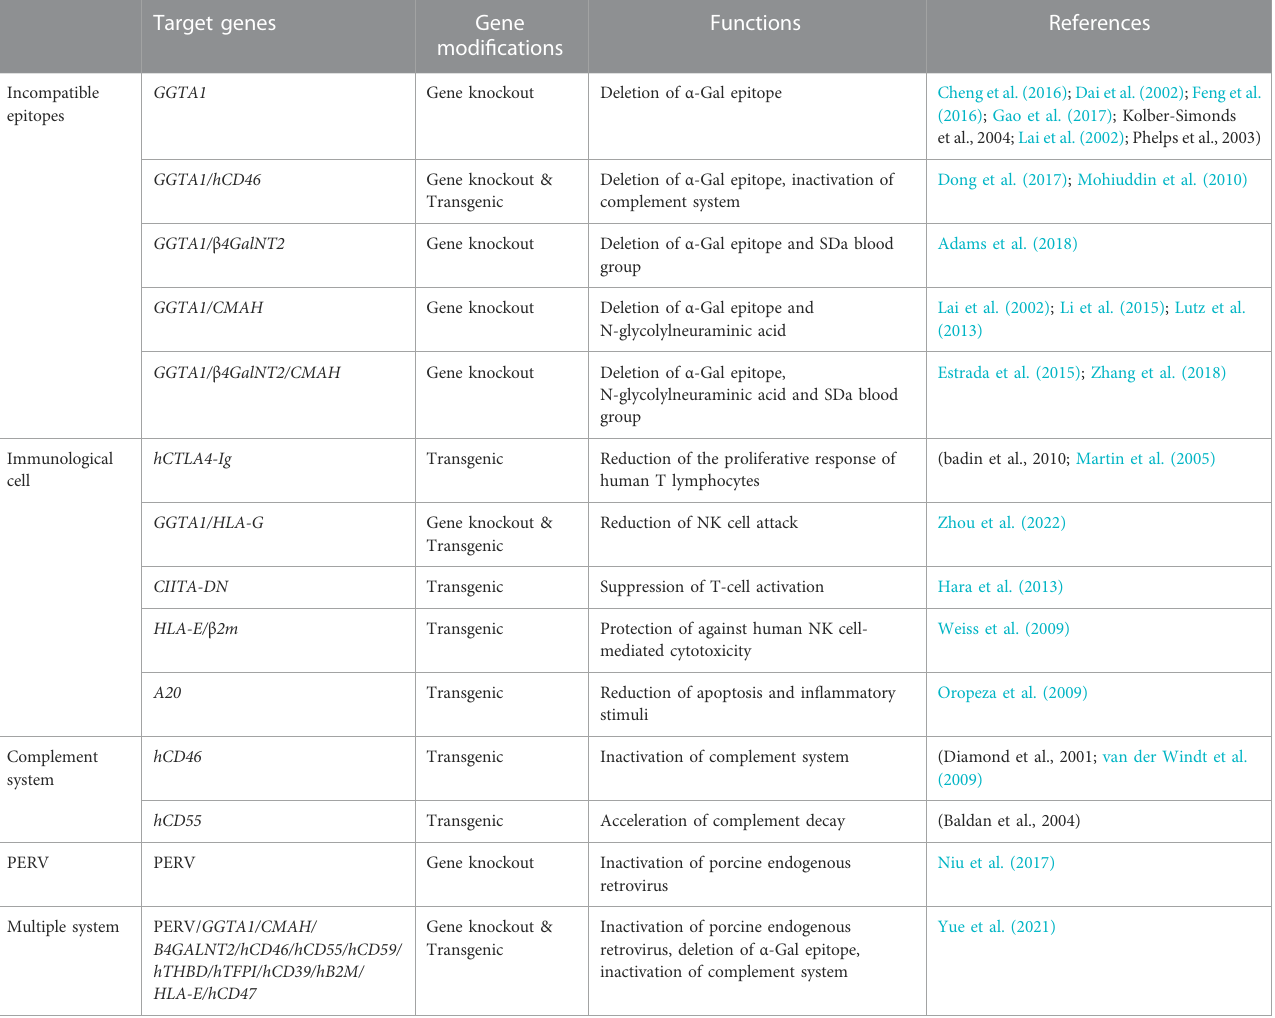
TABLE 1 Genetically modi fi ed pigs for